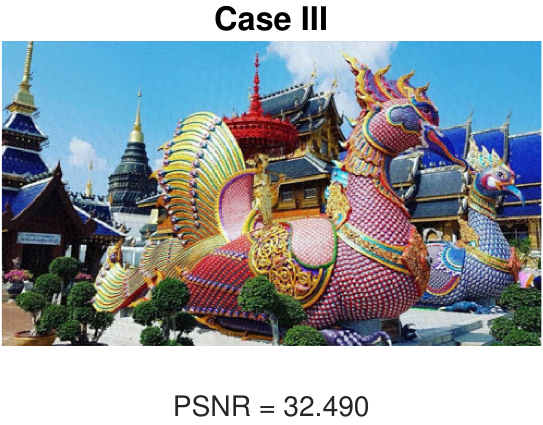
Figure 26. The reconstructed RGB image with their PSNRs for three different cases using the proposed algorithm presented in 10,000 iterations, respectively.